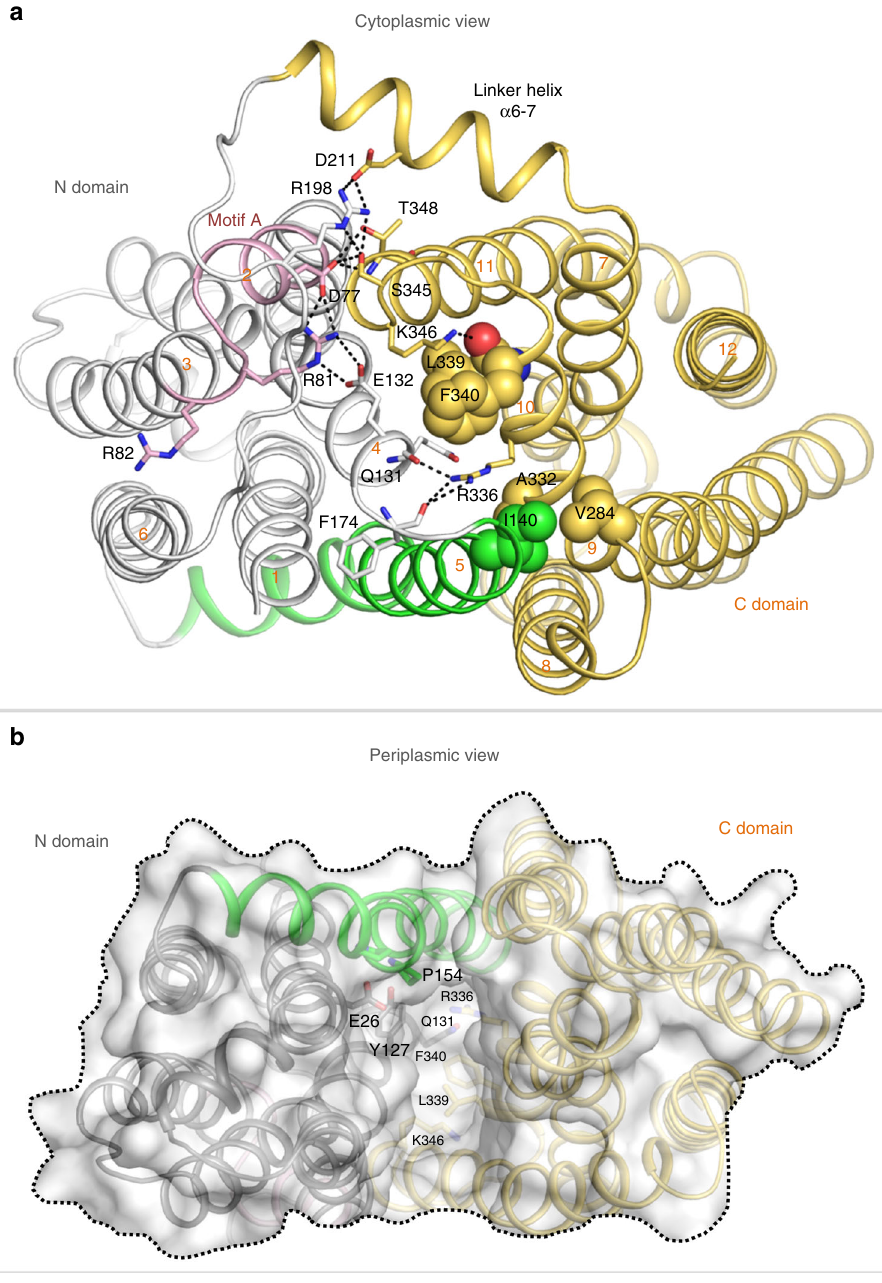
Fig. 2 Cytoplasmic and periplasmic faces of MdfA in the outward open conformation. a The cytoplasmic entrance to the ligand-binding pocket is closed in the O o conformation by numerous interactions between the N- and C-lobes (view obtained by rotating Fig. 1 90° about a horizontal x -axis). The N-terminus of TM5 juxtaposes the C-termini of TM8 and TM10, and the N-terminus of TM11 nestles between the C-termini of TM2 and TM4. Hydrophobic sidechains from each of these helices pack against each other to form a hydrophobic plug that seals off access to the transporter cavity from the cytoplasmic face, supported by additional mutually favorable electrostatic interactions. b View from the periplasmic face (following a 180° rotation about a horizontal x -axis), demonstrating the deep cavity between the two domains in the outward open conformation. Dotted line denotes approximate boundary delineated by the bacterial membrane outer lea fl et head